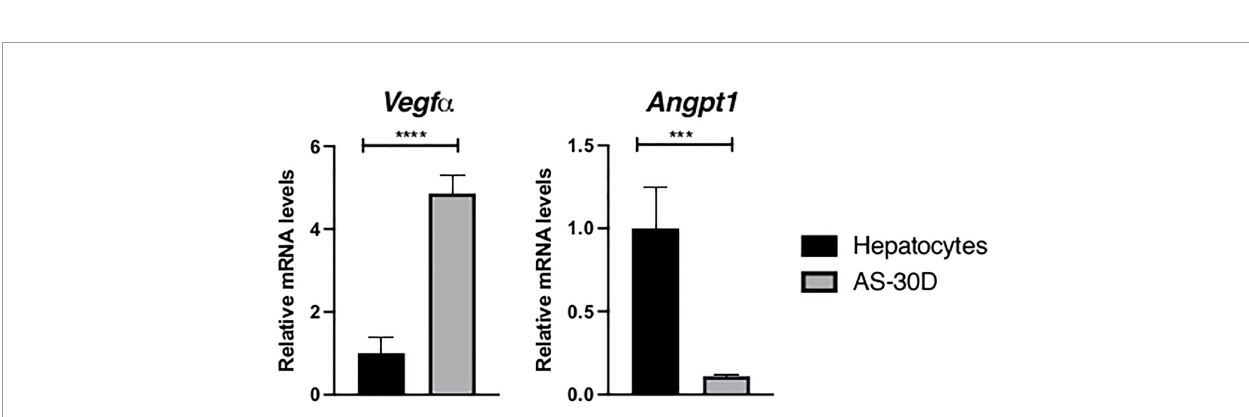
FIGURE 2 | Expression of genes involved in angiogenesis in rat hepatocytes and AS-30D cells. Rat hepatocytes were freshly isolated, and AS-30D samples were obtained from cells from the ascitic fl uid of experimental rats. Data represented as mean ± SD. ***p ≤ 0.001; and ****p ≤